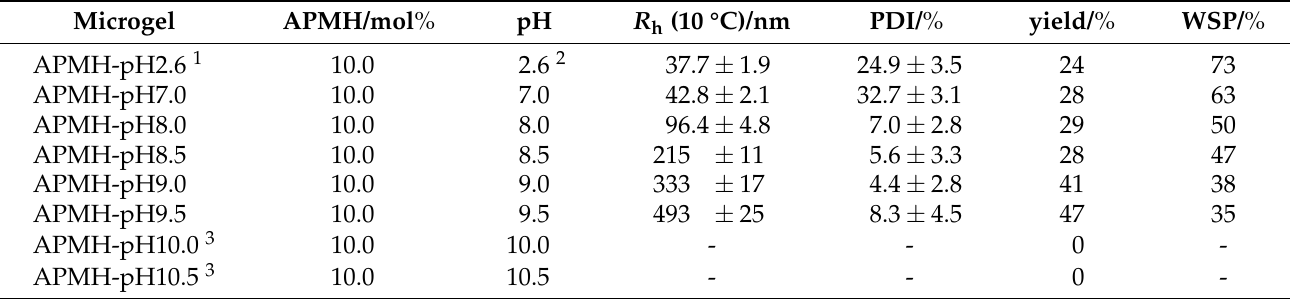
Table 3. Overview on synthesized poly(NIPAM- co -APMH) microgels with 10mol% APMH-feed, synthesized at different reaction pH. Additionally, the hydrodynamic radii and dispersity (PDI) at 10°C, microgel yield and amount of water-soluble polymer (WSP) in the first supernatant of centrifugation are